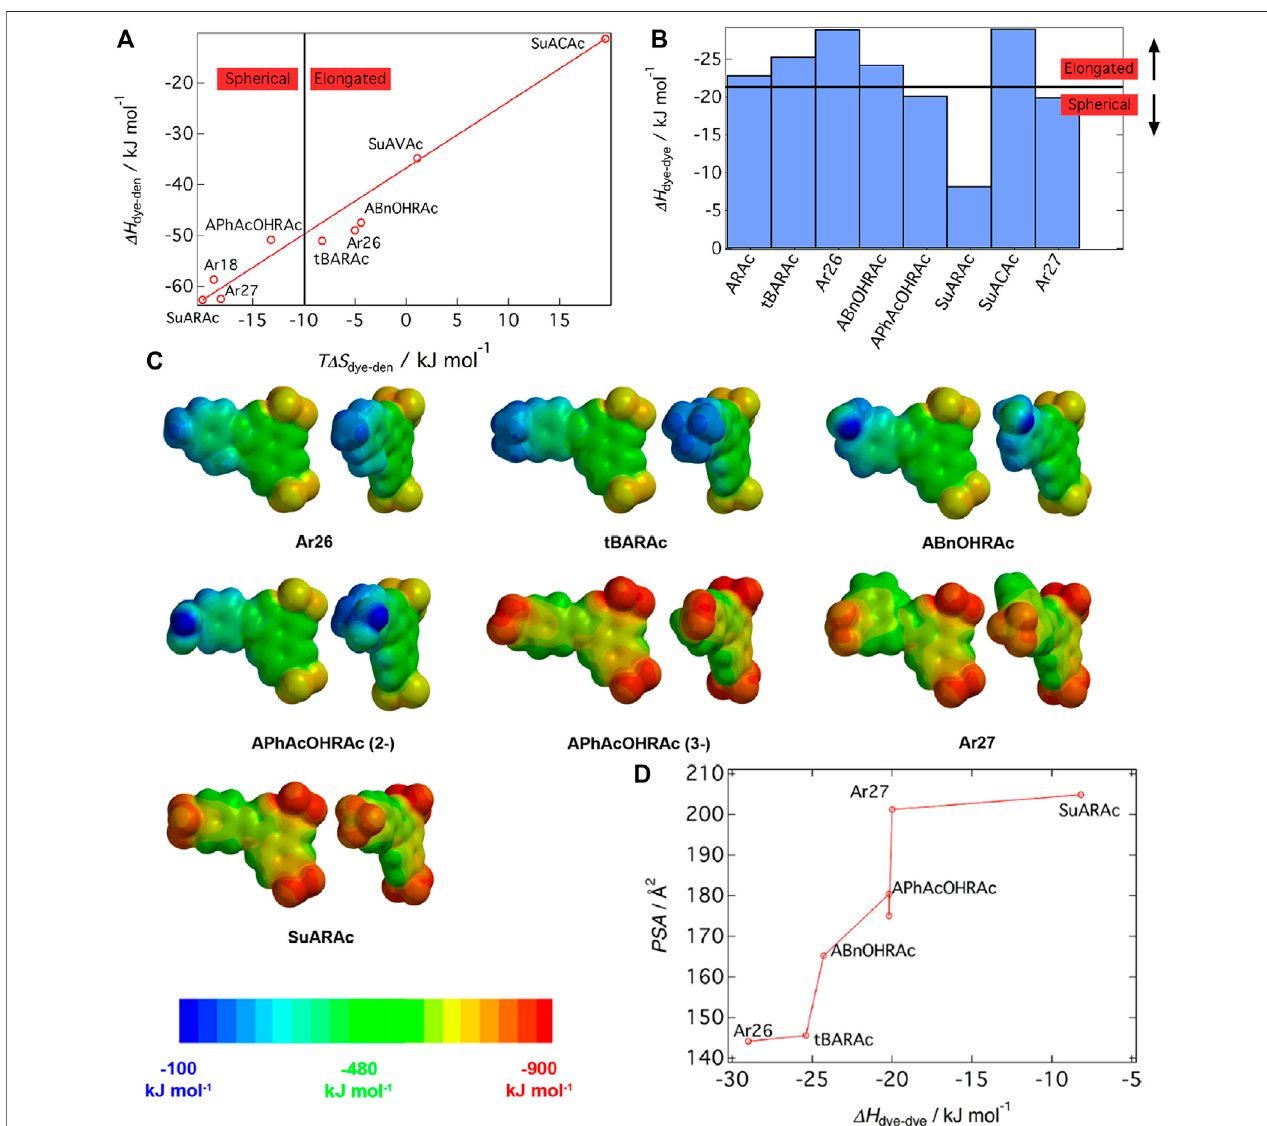
FIGURE 12 | Elucidating the nanoscale shape control in electrostatic self-assembly by an experimental thermodynamics study: (A) Enthalpy-entropy relation for dye-dendrimer interaction; (B) Assemblysymmetrydependingondye-dyeinteraction enthalpy; (C) Electrostaticpotential atthemolecularsurfaceforthedye molecules fromDFTcalculation:eachtopview (left) andfrontview (right) ; (D) masterplotofthepolarsurfaceareaofthemoleculesasafunctionof Δ H dye − dye (Marianietal.,2016a). Reprinted with permission. Copyright © 2015 American Chemical Society.